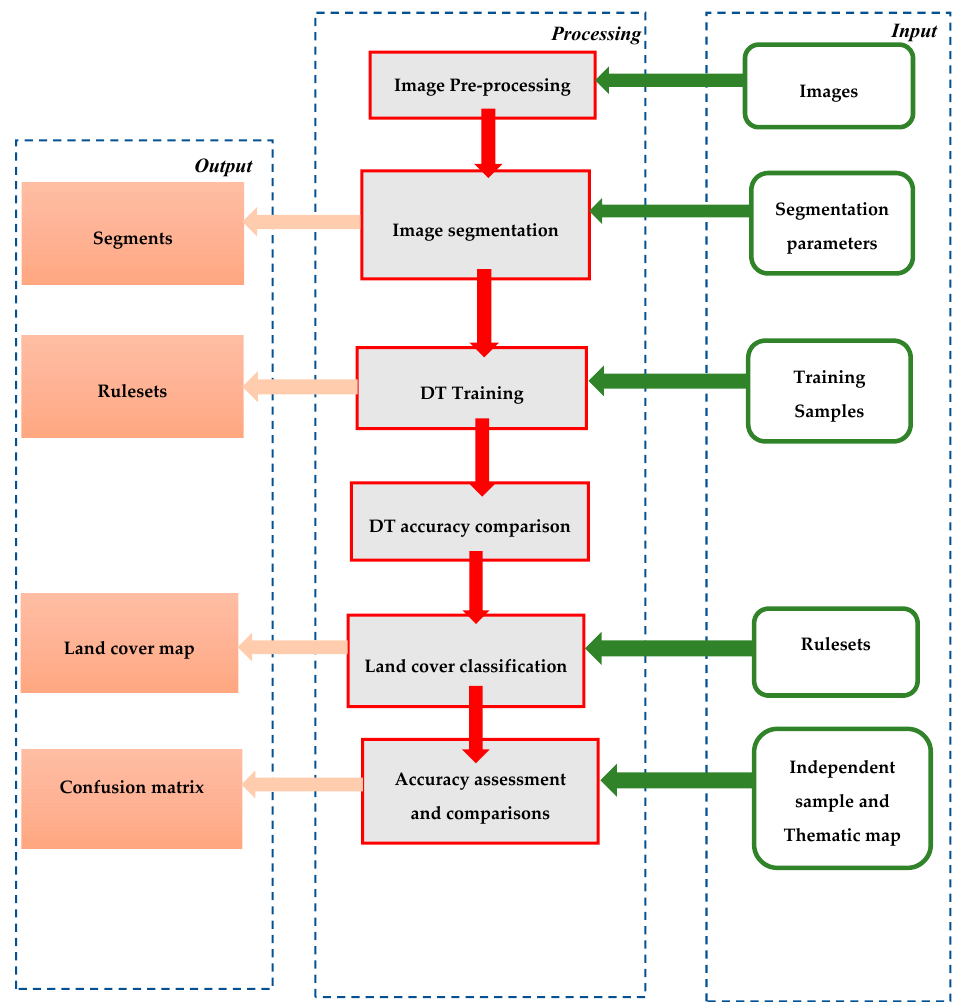
Figure 2. Flow chart of the steps used in the study.